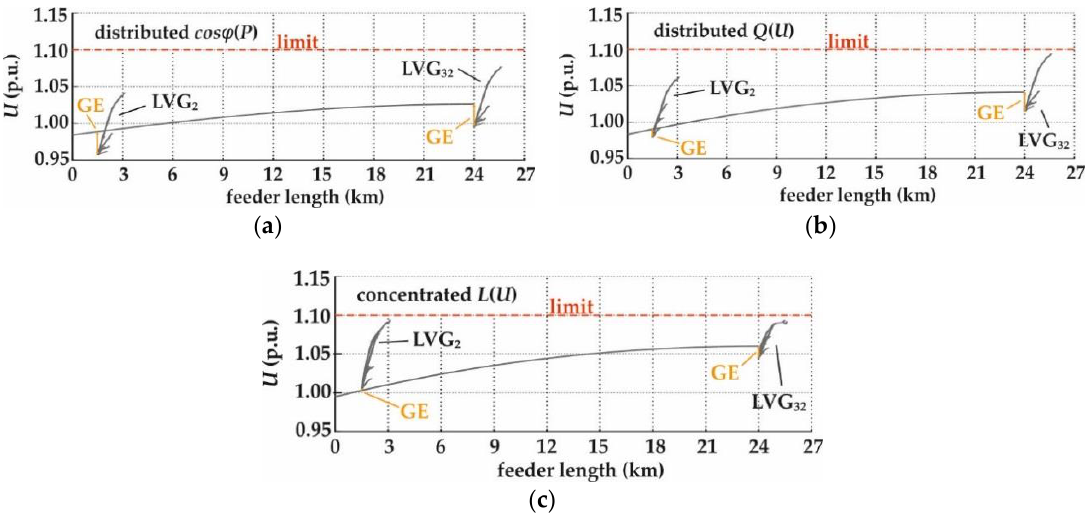
Figure 24. Voltage profiles of the MV feeder and of the second and 32 nd LVGs for different control strategies at t crit = 12:12: ( a ) cos ϕ ( P ); ( b ) Q ( U ); and ( c ) L ( U ). Table 3. Reactive power exchange through supplying transformer (STR), on-load tap changer (OLTC) position change, and the global effect in distribution transformers (DTR) level for different control strategies in real low-voltage grids (LVGs). ( Mvar Q ex STR